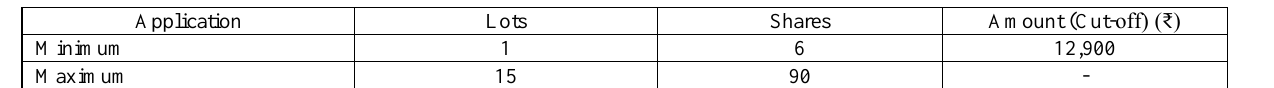
Table 3. Lot Size details of Paytm